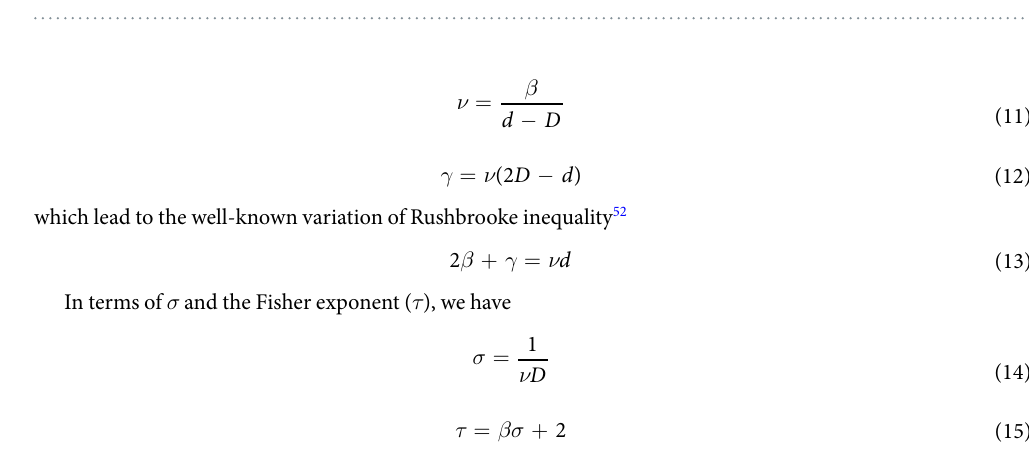
, ( d ) data collapse ν